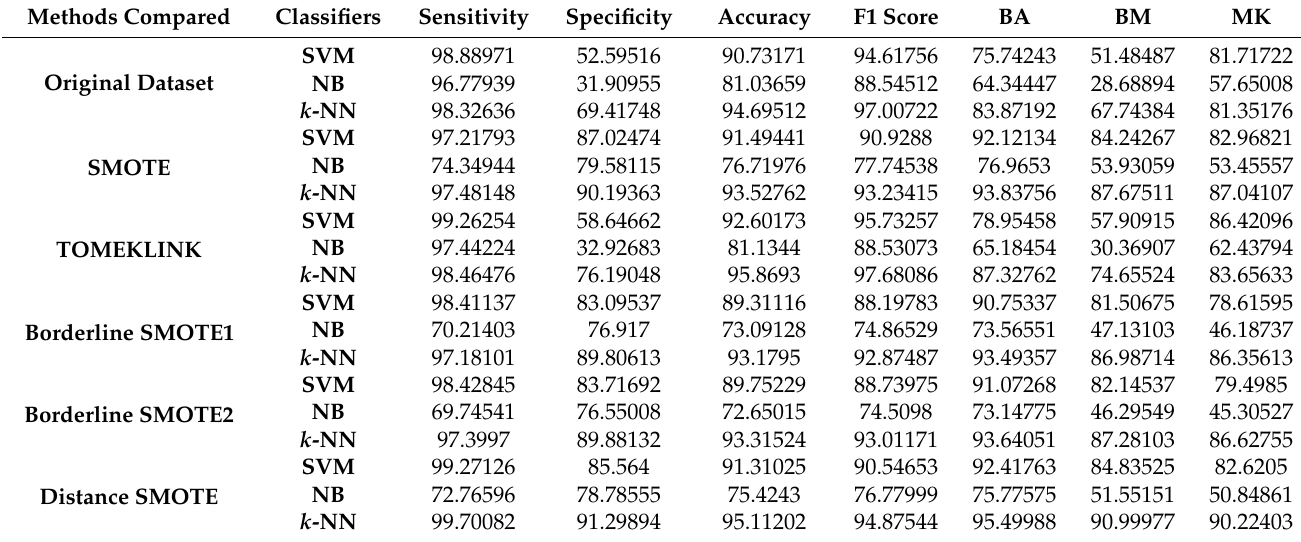
Table 7. Performance recognition (in %) of Page Blocks0